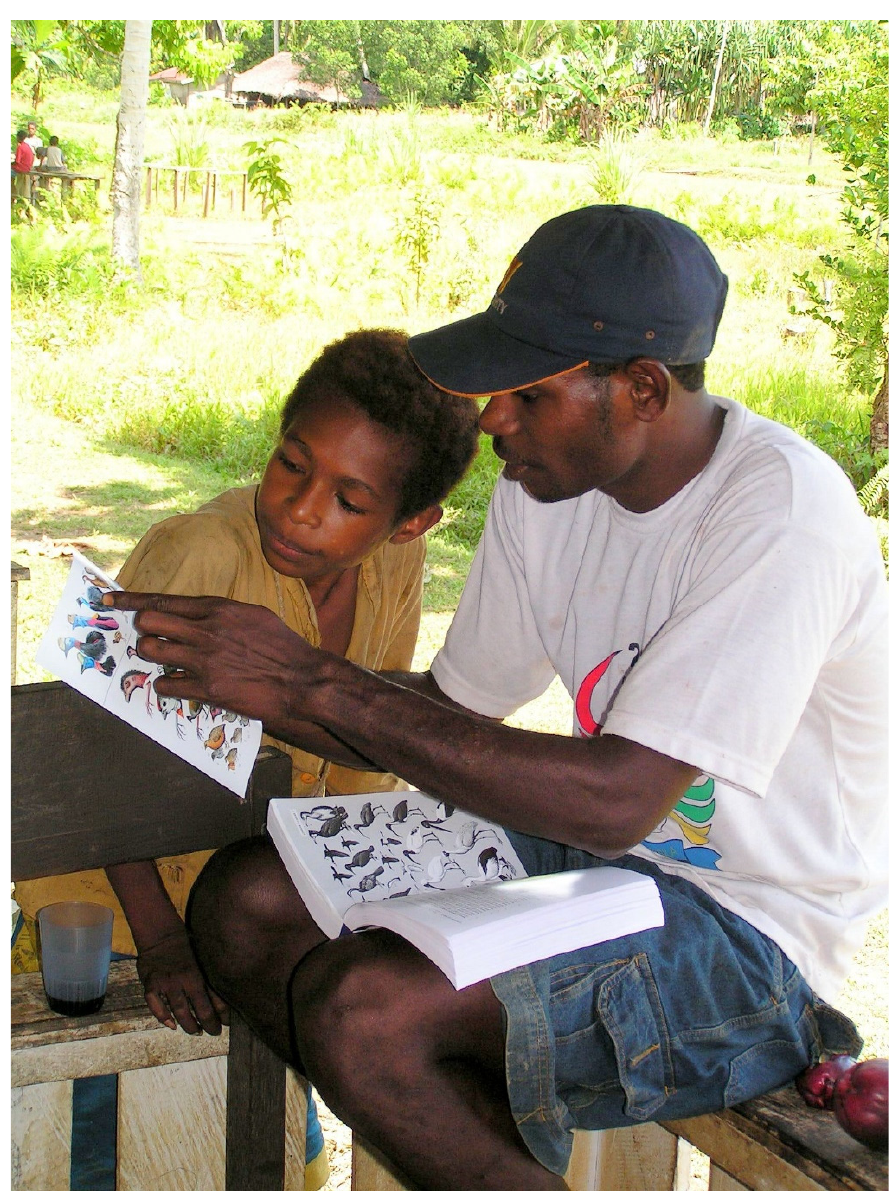
Figure 5. Collaboration stimulates curiosity and pride: here, local informant, Pak Parman, uses one of the research team’s bird-identification books to explain to a child how the Northern Cassowaries, common in the nearby forests, are special to the region and do not occur elsewhere. Credit: DS.